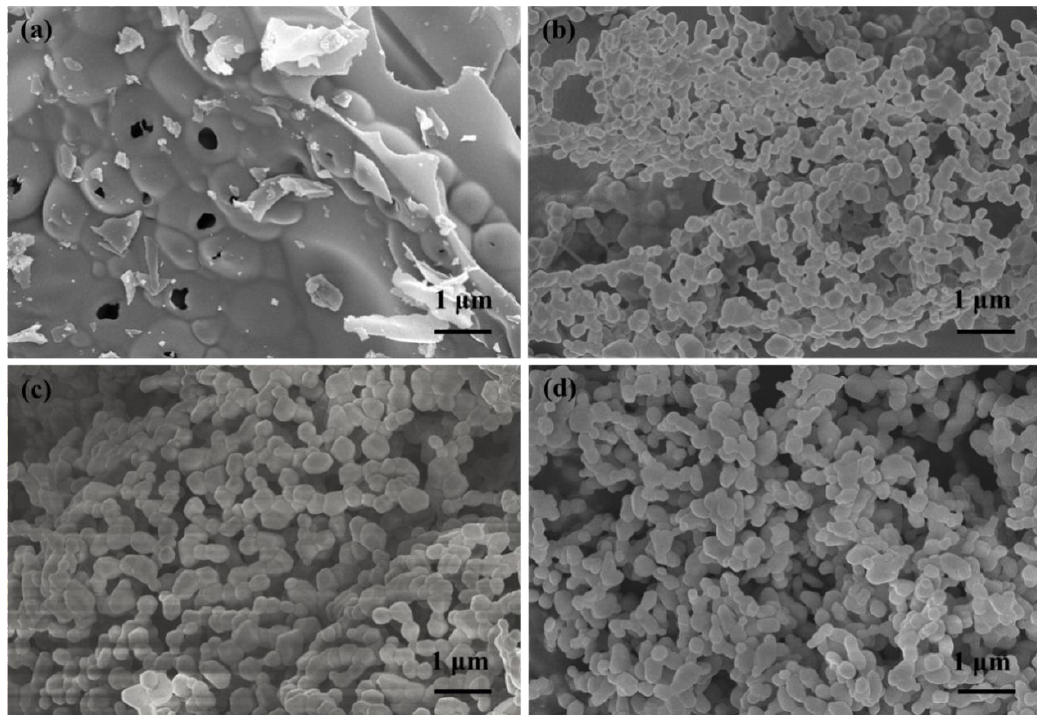
Figure 4. Scanning electron microscopy photographs of samples, ( a ) precursor of S1, ( b ) S1-900, ( c ) S1-1000, and ( d ) S12.